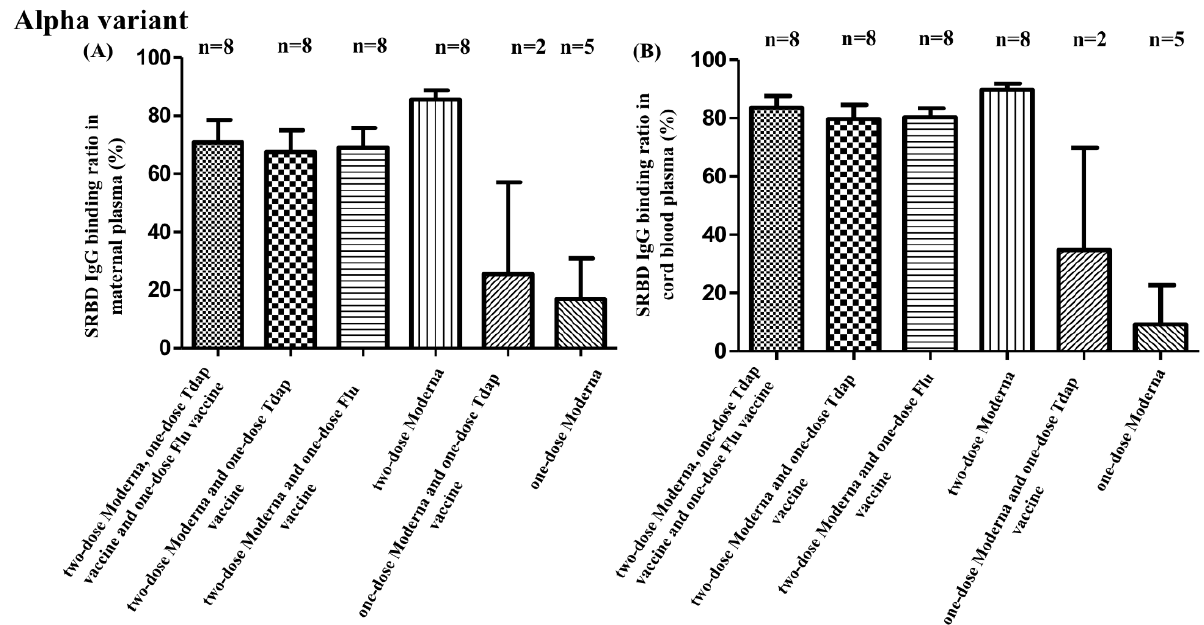
Figure 1. ( A ) SRBD IgG binding ratio against Alpha variants from maternal plasma in different vaccine combinations. ( B ) SRBD IgG binding ratio against Alpha variants from neonatal cord blood in different vaccine combinations. Tdap vaccine, tetanus toxoid, reduced diphtheria toxoid, and acellular pertussis vaccine; flu vaccine, influenza vaccine.